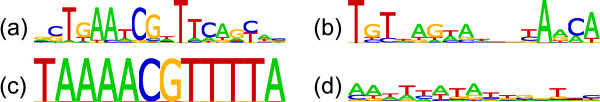
Diversity of E. coli motifs. Sequence logos for four E. coli motifs illustrate the diversity of motifs in terms of information content profile. (a) FruR has a number of perfectly conserved positions in the centre of the motif, flanked by positions which are less well-conserved. (b) The gapped motif of DeoR illustrates the opposite: two well-conserved segments are separated by an unconserved ‘gap’. (c) All positions in the MalI motif are perfectly conserved. (d) The Nac motif has few well-conserved positions.